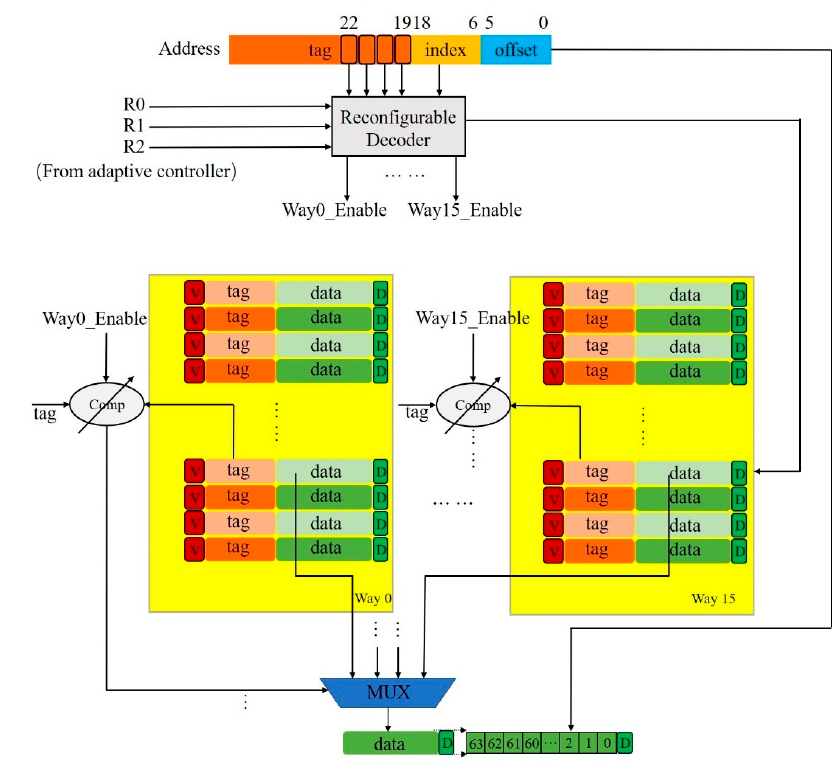
Figure 8. Hardware architecture of associativity-reconfigurable cache.